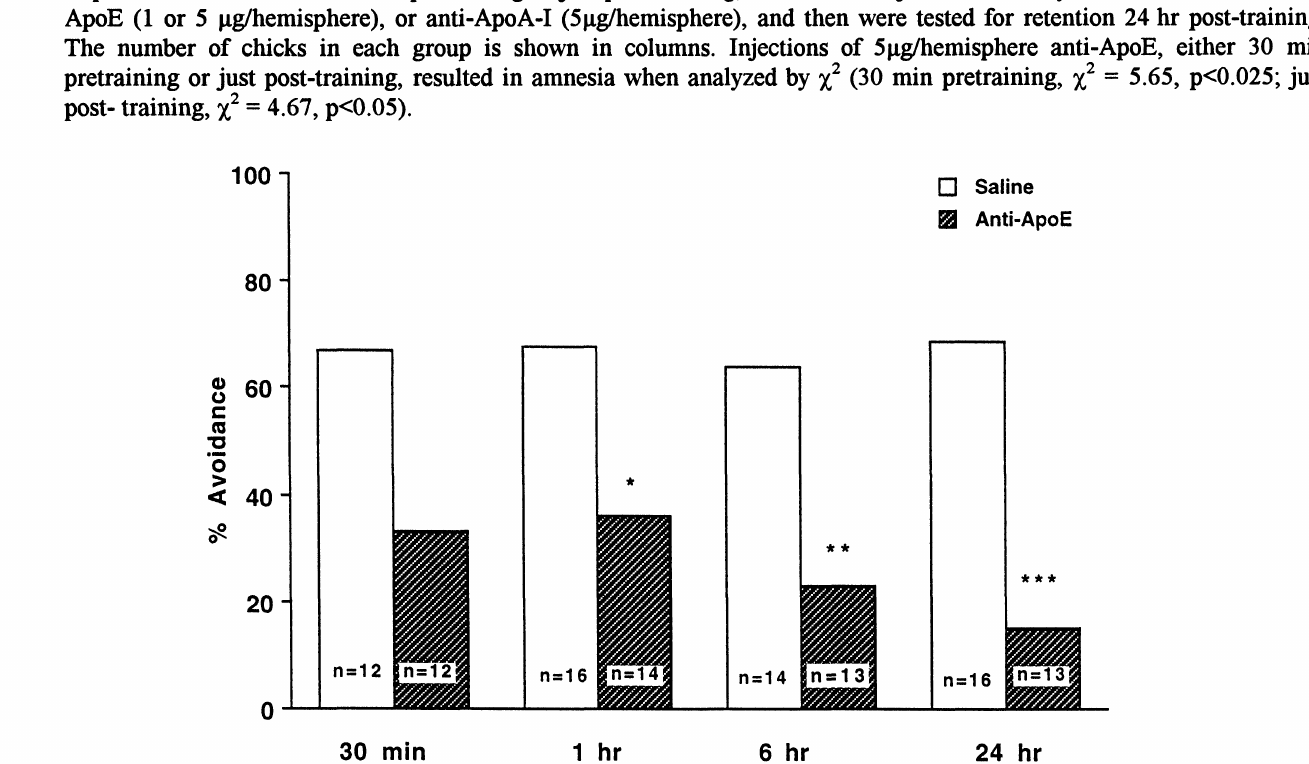
Fig. 5: Time of onset of amnesia for a passive avoidance task in chicks injected with anti-ApoE. Chicks were pretrained, trained, and injected with either saline or anti-ApoE (5tg/hemisphere) 30 min pretraining, as described in the Experimental section. Different groups of chicks were tested for retention at various times post-training. (each chick was trained and tested only once). The number of chicks in each group is shown in columns. 30 min post-training, Z